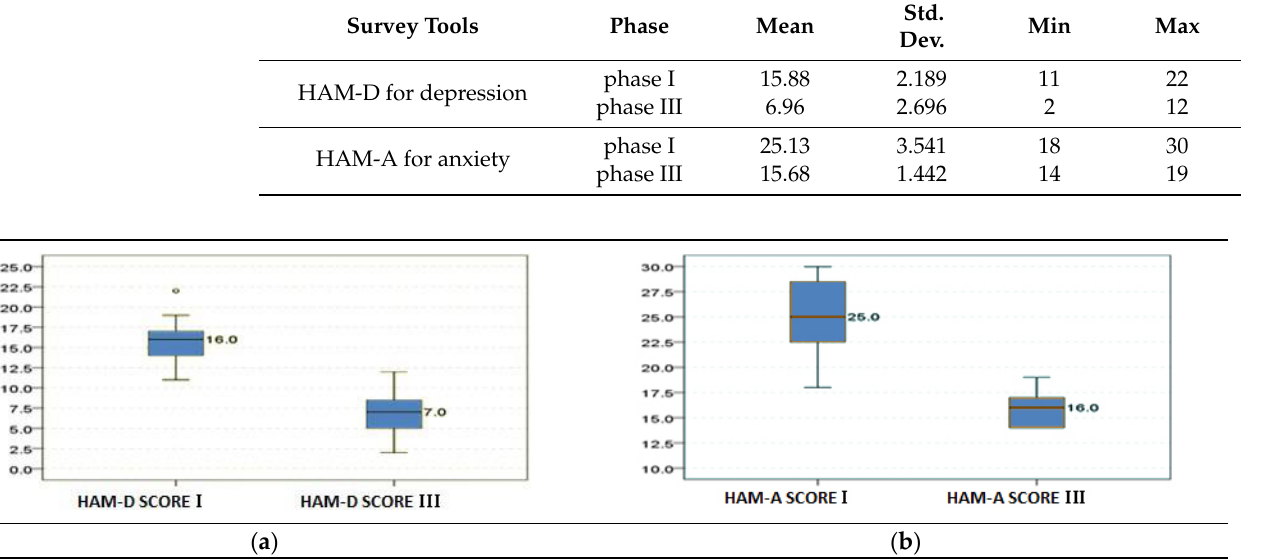
Figure 2. Differences in ( a ) depression and ( b ) anxiety scores between the two studied phases ( N = 120).